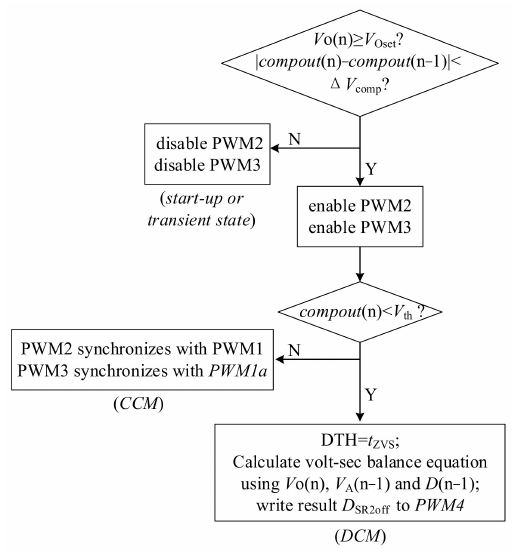
Figure 6. The workflow of circuit state judgement and